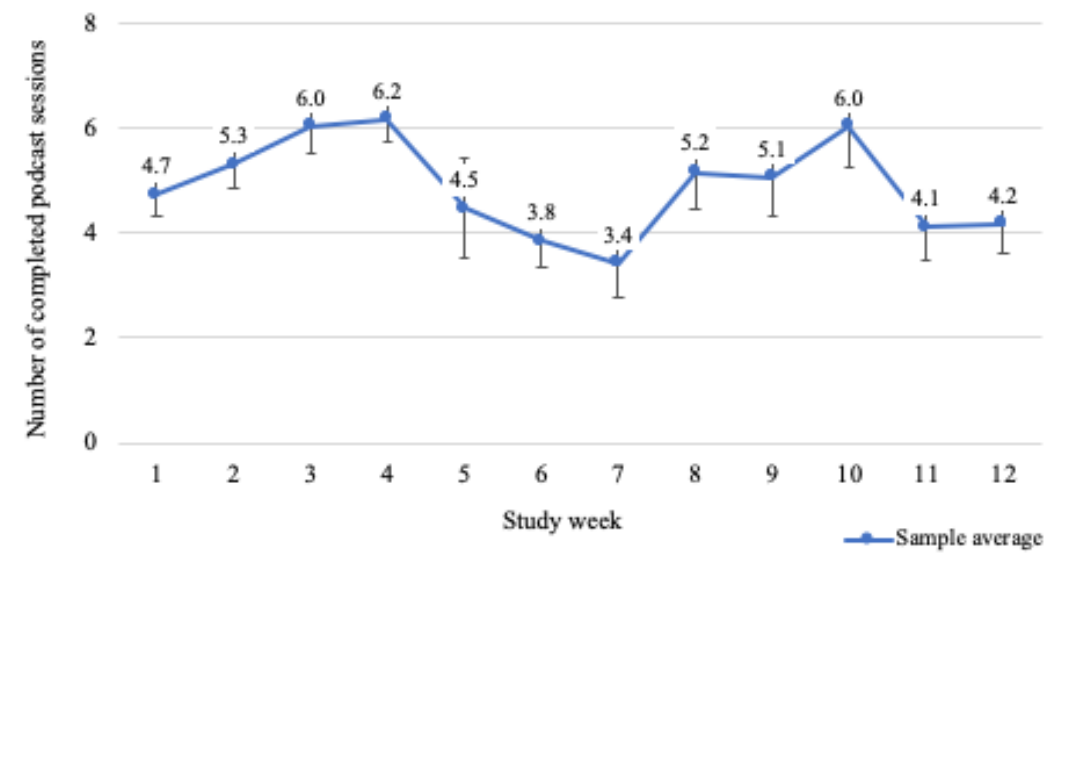
Figure 5. Average podcast sessions completed by